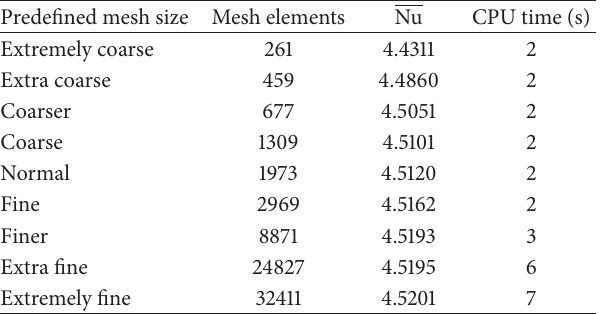
Table 1: Grid sensitivity check at 𝑁 = 5 , 𝑋 0 = 0.5 , 𝐴 = 𝜋/25 , Ra = 10 5 , and 𝐾 𝑟 = 1